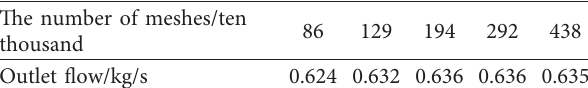
Figure 17: Meshing. (a) Fluid domain meshing. (b) Solid domain meshing. Table 4: Grid independence